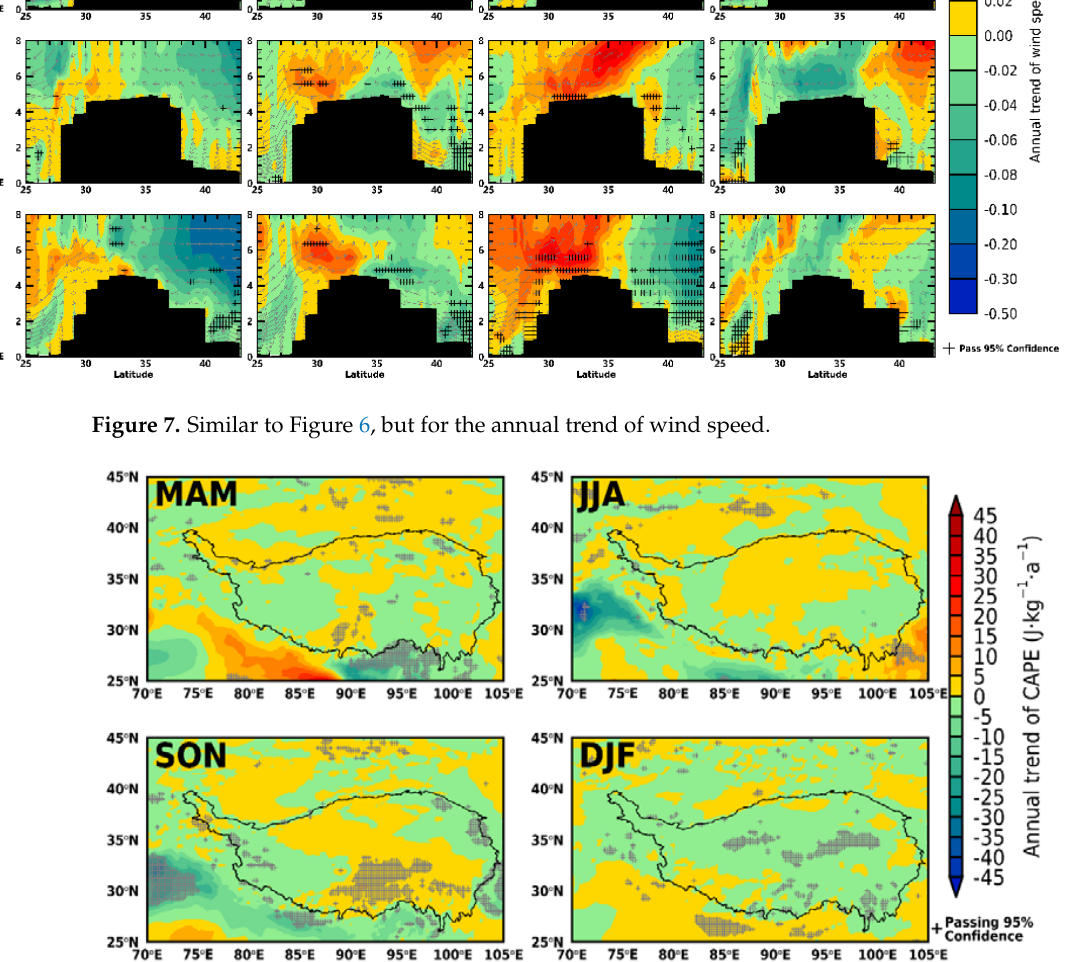
Figure 8. Distributions of the annual trend of seasonal mean CAPE during 2007 − 2020.